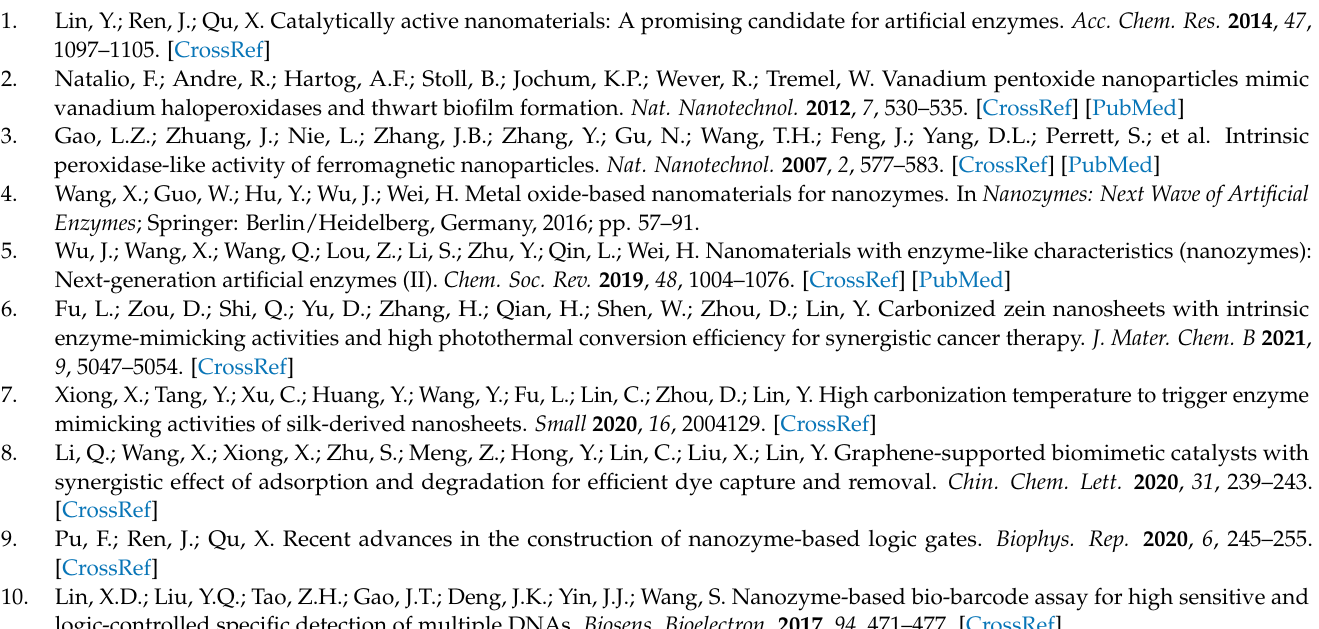
Supplementary Materials: The following are available online, Figure S1: TEM image of Fe 3 O 4 NPs. Figure S2: (a) Wide-angle powder XRD pattern and (b) size distribution of the CeO 2 NPs. Figure S3: Absorbance intensity at 652 nm of TMB reaction solutions treated by (a) UV-light, (b) CeO 2 NPs, and (c) Fe 3 O 4 NPs and H 2 O 2 under different pH. Figure S4: Effect of various saccharides on the appearance properties of oxTMB/GOx reaction solutions: (1) control, (2) lactose, (3) sucrose, (4) maltose, (5) fructose, (6) glucose. Figure S5: Typical photographs of ABTS reaction solutions oxidized by (a) UV-light, (b) CeO 2 , (c) Fe 3 O 4 /H 2 O 2 , and ABTS • + reaction solutions reduced by